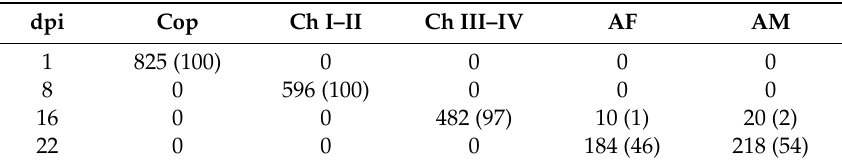
Table 1. Summary of the number and frequency (%) of each developmental stage of Caligus rogercresseyi in all infested fish throughout the experiment.